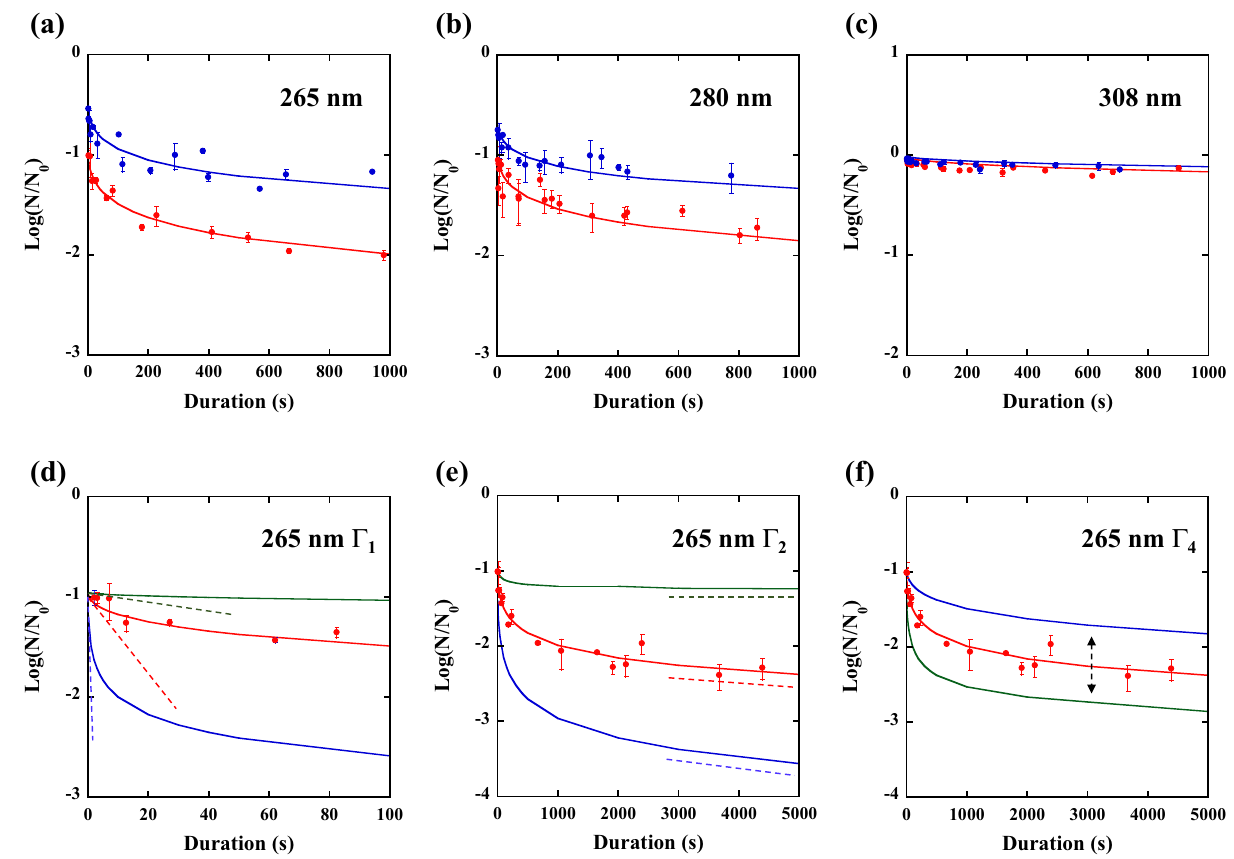
Figure 2. Experimental plots of the inactivation ratio [Log(N/N 0 )] for various irradiation durations (and various irradiances) at doses of 10 mJ/cm 2 (red circles) and 5 mJ/cm 2 (blue circles) and irradiation wavelengths of ( a ) 265 nm, ( b ) 280 nm, and ( c ) 308 nm. The red or blue line represents the theoretically fitted inactivation ratio as a function of irradiation duration at a constant dose (red: 10 mJ/cm 2 , blue: 5 mJ/cm 2 ) but different irradiance conditions. ( d ) Determination of Γ 1 by the initial slope of the curve for 265 nm and 10 mJ/cm 2 results, where the green curve is described by Γ 1 = 2 × 10 −4 cm 3 /s, the red curve is described by Γ 1 = 2 × 10 −3 cm 3 /s, and the blue curve is described by Γ 1 = 2 × 10 −2 cm 3 /s. ( e ) Determination of Γ 2 by the tail slope of the curve for 265 nm and 10 mJ/cm 2 results, where the green curve is described by Γ 2 = 0.07 cm 2 /mJ, the red curve is described by Γ 2 = 0.7 cm 2 /mJ, and the blue curve is described by Γ 2 = 7.0 cm 2 /mJ. ( f ) Determination of Γ 4 by the tail height of the curve for 265 nm and 10 mJ/cm 2 results, where the green curve is described by Γ 4 = 2.8 cm 3 /s, the red curve is described by Γ 4 = 28 cm 3 /s (red circles are experimental results), and the blue curve is described by Γ 4 = 280 cm 3